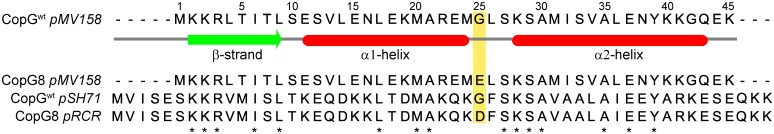
Sequence alignment of the CopG-like proteins encoded by wt and mutant replicons of the pMV158 family. CopG proteins encoded by rolling-circle replicating plasmids pSH71 and pRCR were aligned with the amino acid sequence of pMV158-encoded CopG, to which the indicated numbering and secondary structure regions correspond. The Gly residue of the turn connecting α1- and α2- helices is framed. In the CopG8 variants encoded by a copy-up plasmid mutant derived from pMV158 and by pRCR (as well as their derivatives pRCR12 and pRCR-PM), Glu and Asp residues substitute, respectively, the Gly of the turn.